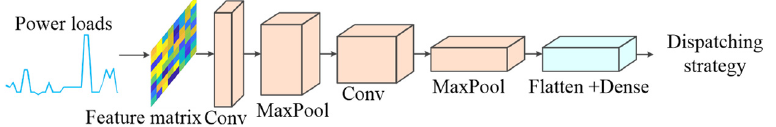
Figure 3. A simple structure of CNN.